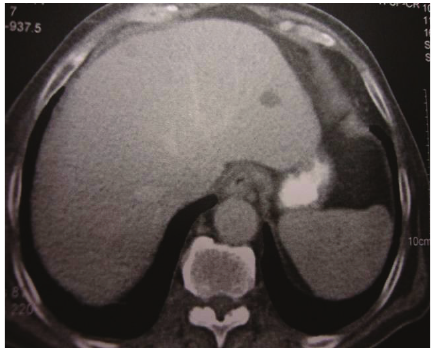
Figure 4: Abdominal CT imaging 3 months after administration of anti-TB agents, showing reduction of the hypodense lesions and of the retroperitoneal